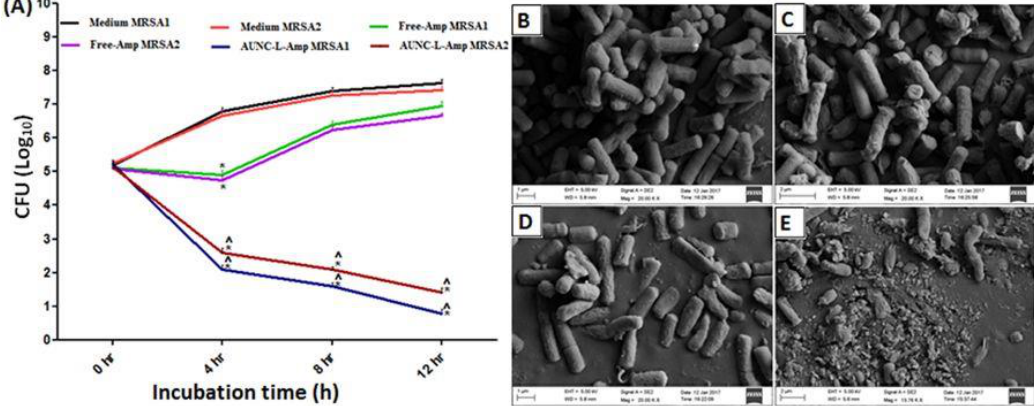
Figure 7. ( A ) Antimicrobial activities of AuNC-L-Amp and free-Amp at different incubation times for MRSA1 and 2. SEM images of MRSA incubation with ( B ) PBS, ( C ) AuNC-L, ( D ) Free-Amp and ( E ) AuNC-L-Amp. SEM images indicate that AuNC-L and free-Amp did not cause the changes of bacterial morphology. On the other hand, AuNC-L-Amp induced the cellular structure of MRSA. Reproduced with permission from Reference [79]. Copyright © 2018, Springer Nature.